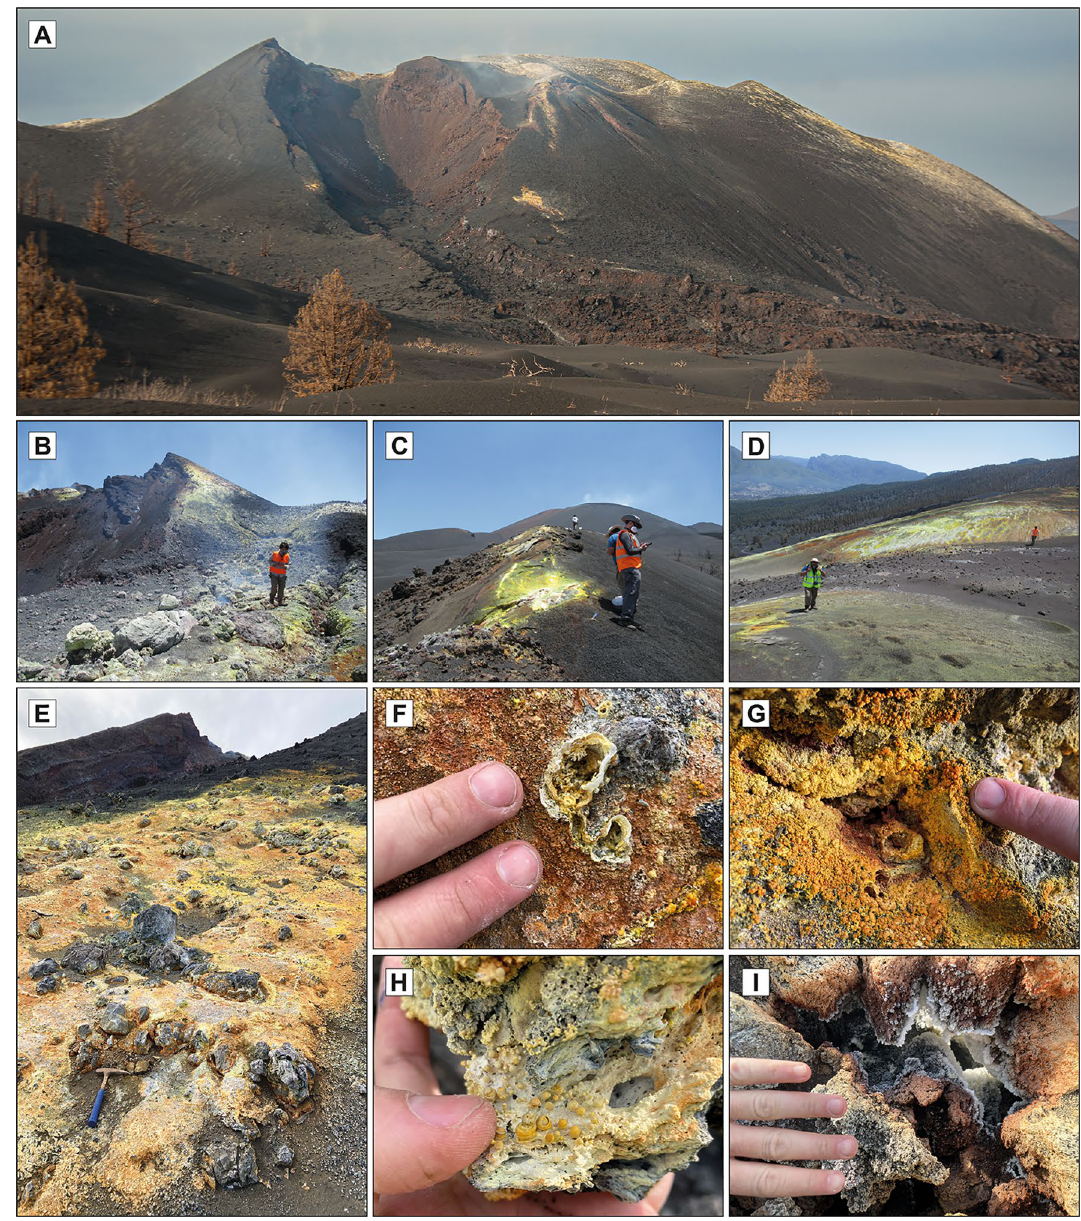
Figure 4. Fumarolic efflorescent patches located in the vicinities of the main craters of the Tajogaite volcano. ( A ) General view of crater “J” (Fig. 2) in which it is possible to distinguish fumarolic efflorescent patches. ( B , C ) Fumarolic mineralization formed along secondary fractures with predominance of native sulphur. Sampling points 22 and 23 (Fig. 2). ( D ) Native sulphur mineralization formed on pyroclastic materials due to degassing through porosity and microfractures. Sampling point 9 (Fig. 2). ( D ) General view of typical fumarolic mineralization formed on pyroclastic materials mainly composed of Al–Mg–Ca–Na fluorides and associated chlorides. Sampling point 15 (Fig. 2). ( E–G ) Detail of the concentric morphologies associated with effusive degassing formed by Al–Mg–Ca–Na fluorides. ( H ) Botryoidal aggregates of verneite (Na 2 Ca 3 Al 2 F 14 ) formed by the activity of proximal fumaroles located close to the main craters. Sampling point 13 (Fig. 2). ( I ) Whitish aggregates of skeletal microcrystals of Al–Mg–Ca–Na fluorides associated with fumarolic activity on cavities in the volcanic materials. Sampling point 13 (Fig. formations of yellowish-orange tones (Fig. 4h) as well as skeletal microcrystalline aggregates of variable coloura- tion developed in cavities (Fig. 4i). Mineralogy of fumaroles. The mineralogical characterisation of the Tajogaite fumarole samples revealed a very complex mineral assemblage formed by different episodes of overprinting. Due to the strong predominance of cryptocrystalline phases, we considered powder XRD to be a particularly well-suited technique to identify this